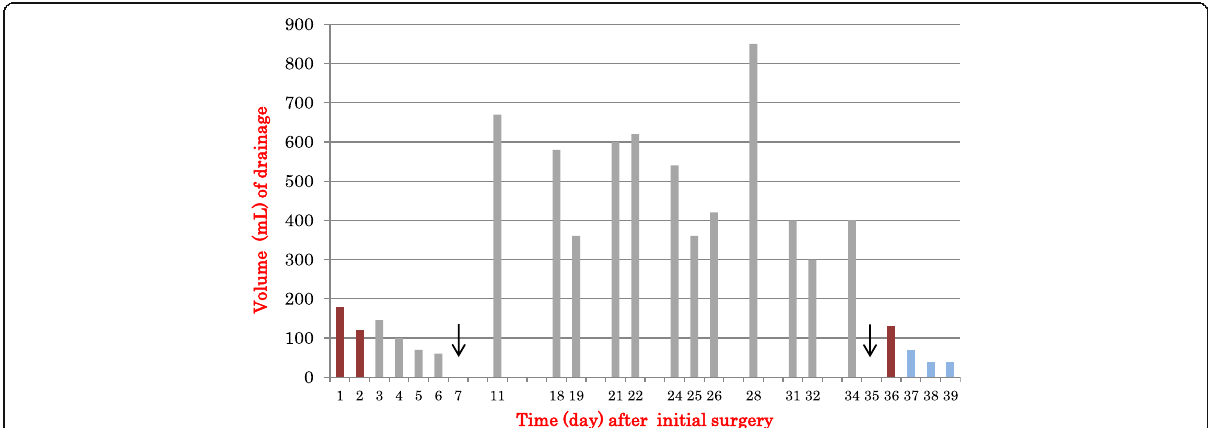
Fig. 2 Volume of the bloody drainage fluid (red bars) and milky drainage fluid (gray bars) after the initial surgery. The fluid was slightly milky in color from POD 3. The drain was removed POD 6 with 60 mL per day. The patient was discharged on postoperative day (POD) 7(black arrow). Total mastectomy was done on POD 35 (black arrow). After POD 36, the blue bars indicate the volume of the discharge from the drain; this fluid was serous rather than milky in color